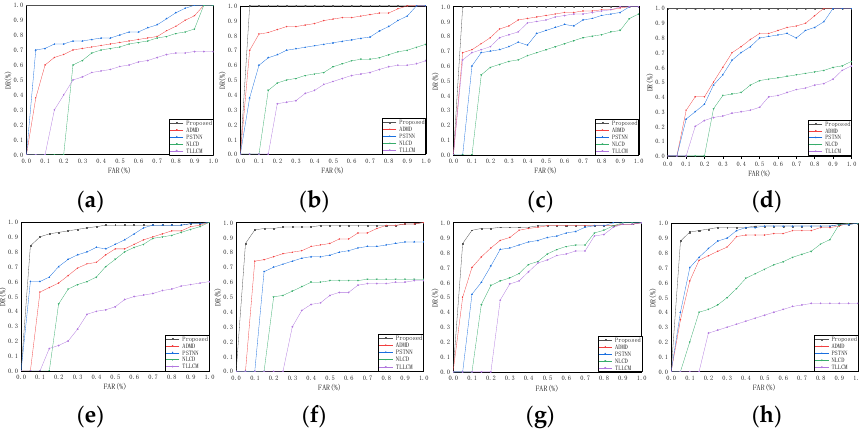
Figure 21. ( a – h ) is ROC curves of detection results of eight real sequences.